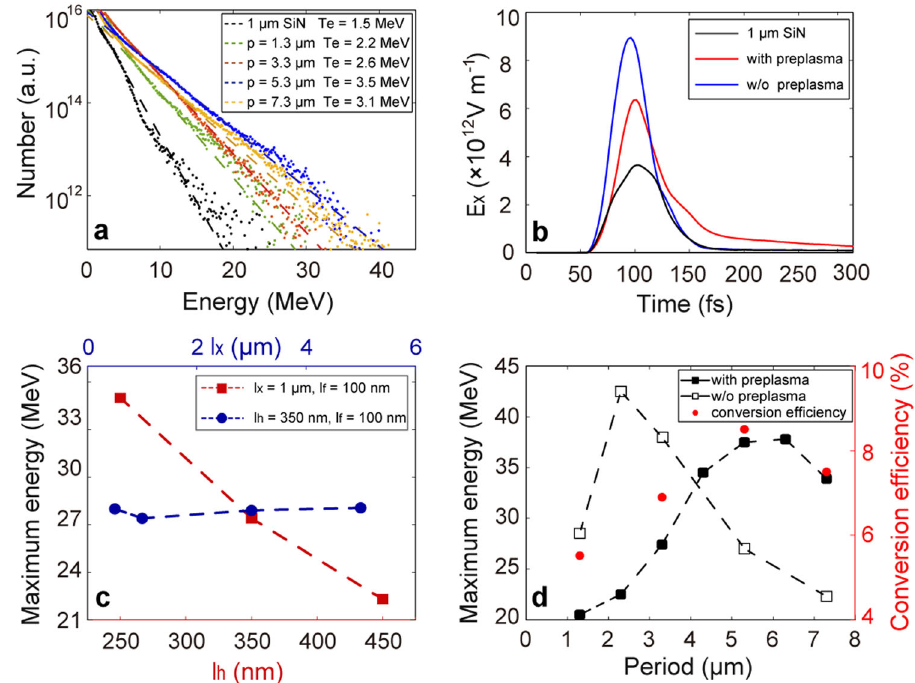
Fig. 4 Parametric simulation results for proton acceleration. a The electron spectra and temperature under pre-plasma conditions. The dashed lines are fi ts to the data. b The temporal evolution of E μ m ( x ) × 8 μ m ( y ) behind the substrate. c Proton maximum energy as a x which is averaged in an area of 2 function of l h and l x scale length. d Proton maximum energy versus wire period with and without pre-plasma, while the diameter and height of the wire are 0.4 and 2.5 μ m, respectively. The conversion ef fi ciencies from the simulations in d are calibrated with the average value measured in experiment for p = 3.3 μ m which gives a fi xed ratio for all simulation